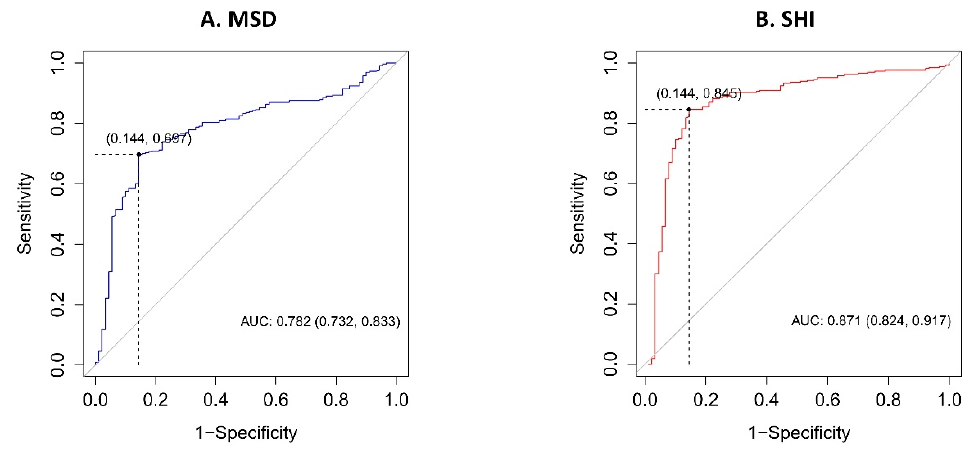
Figure 3. Receiver operating characteristic (ROC) curve of uric acid stones for ( A ) mean stone density (MSD), AUC = 0.782 (95% confidence interval [CI]: 0.732–0.833), cutpoint of 572.3 HU; ( B ) stone heterogeneity index (SHI), AUC = 0.871 (95% CI: 0.824–0.917), cutpoint of 140.4 HU. AUC, area under ROC curve; HU, Hounsfield unit.